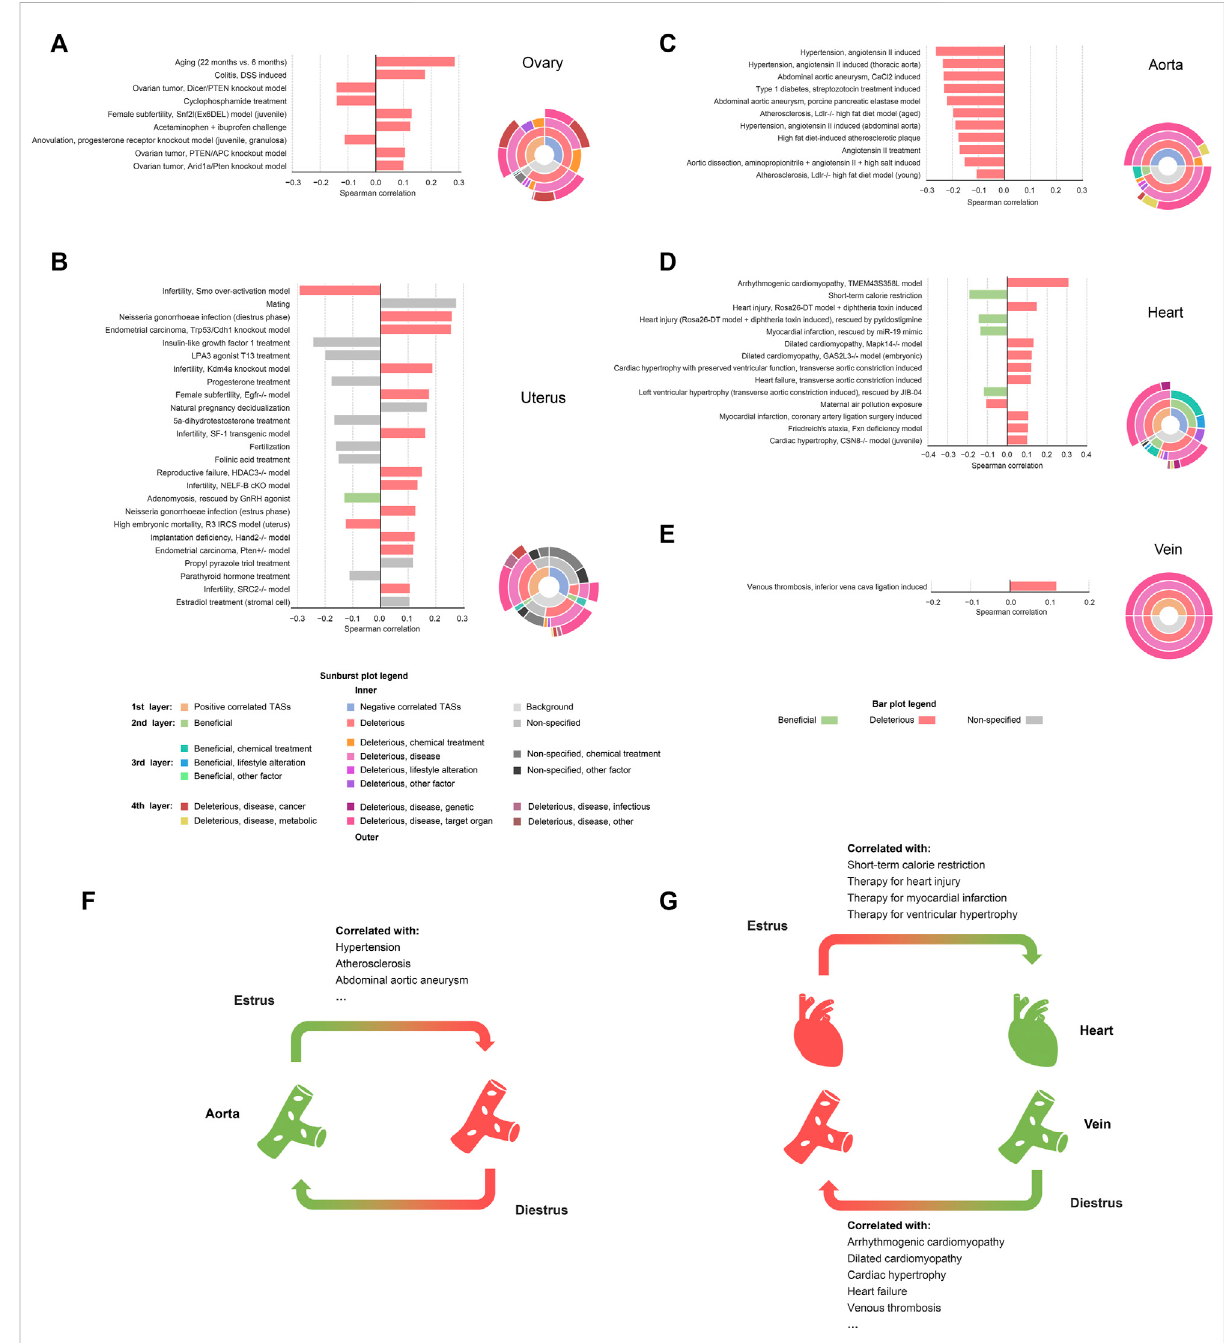
FIGURE 4 Signi fi cantly correlated relationships between estrus-induced TASs and curated TASs in reproductive tissues and cardiovascular tissues. Signi fi cantly correlated relationships in reproductive tissues and cardiovascular tissues (A) ovary (B) uterus (C) aorta (D) heart and (E) vein. Bar plots illustrate the curated TASs that are signi fi cantly correlated with the estrus-induced TASs in corresponding tissues (|SCC| ≥ 0.1). Sunburst plots show the hierarchical af fi liation relationships among the multi-level labels of the positively correlated TASs, the negatively correlated TASs and the background.Duringtheestrouscycle (F) theestrusphaseismoreprotectivetoaortawhile (G)